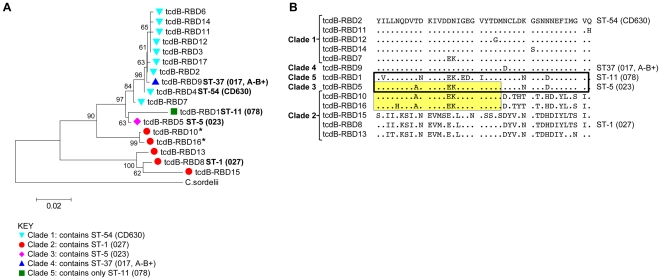
The association of tcdB-RBD alleles and clade is congruent.(A) Neighbour joining tree showing the relationships among the 17 tcdB allele sequences (597nt) and C. sordelii constructed using MEGA with bootstraps calculated using 1000 replicates. Coloured shapes indicate the clade (Fig. 1) with which each tcdB allele is associated. The number of variable nucleotide sites (excluding C. sordelii) was 97/597 (16.2%) and amino acids 42/199 (21.1%). * Indicates putative recombinants derived from clade 2 and clade 3 sequences. C. sordelii was used to root the tree as it encodes the closest known relative to C. difficile tcdB. (B) Alignment of the tcdB-RBD allele variable amino acid sites, relative to the sequence of the CD630 genome strain [51] (clade 1, allele tcdB-2). Alleles tcdB-3, tcdB-4, tcdB-6, and tcdB-17 are not shown as they have an amino acid sequence identical to tcdB-2. The bold box indicates the closely related sequences of clade 3 and clade 5; the yellow shaded box indicates putative clade 2/clade 3 tcdB recombinants; * in (A).